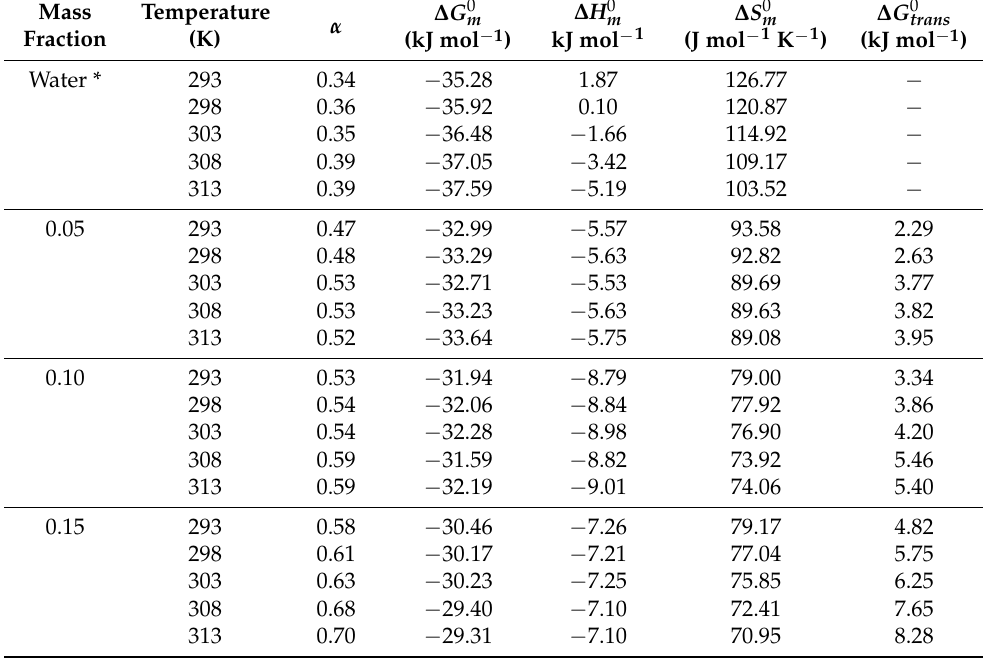
Table 2. Thermodynamic parameters for micellization of SDS in different mass fraction of propane- 1,2-diol.